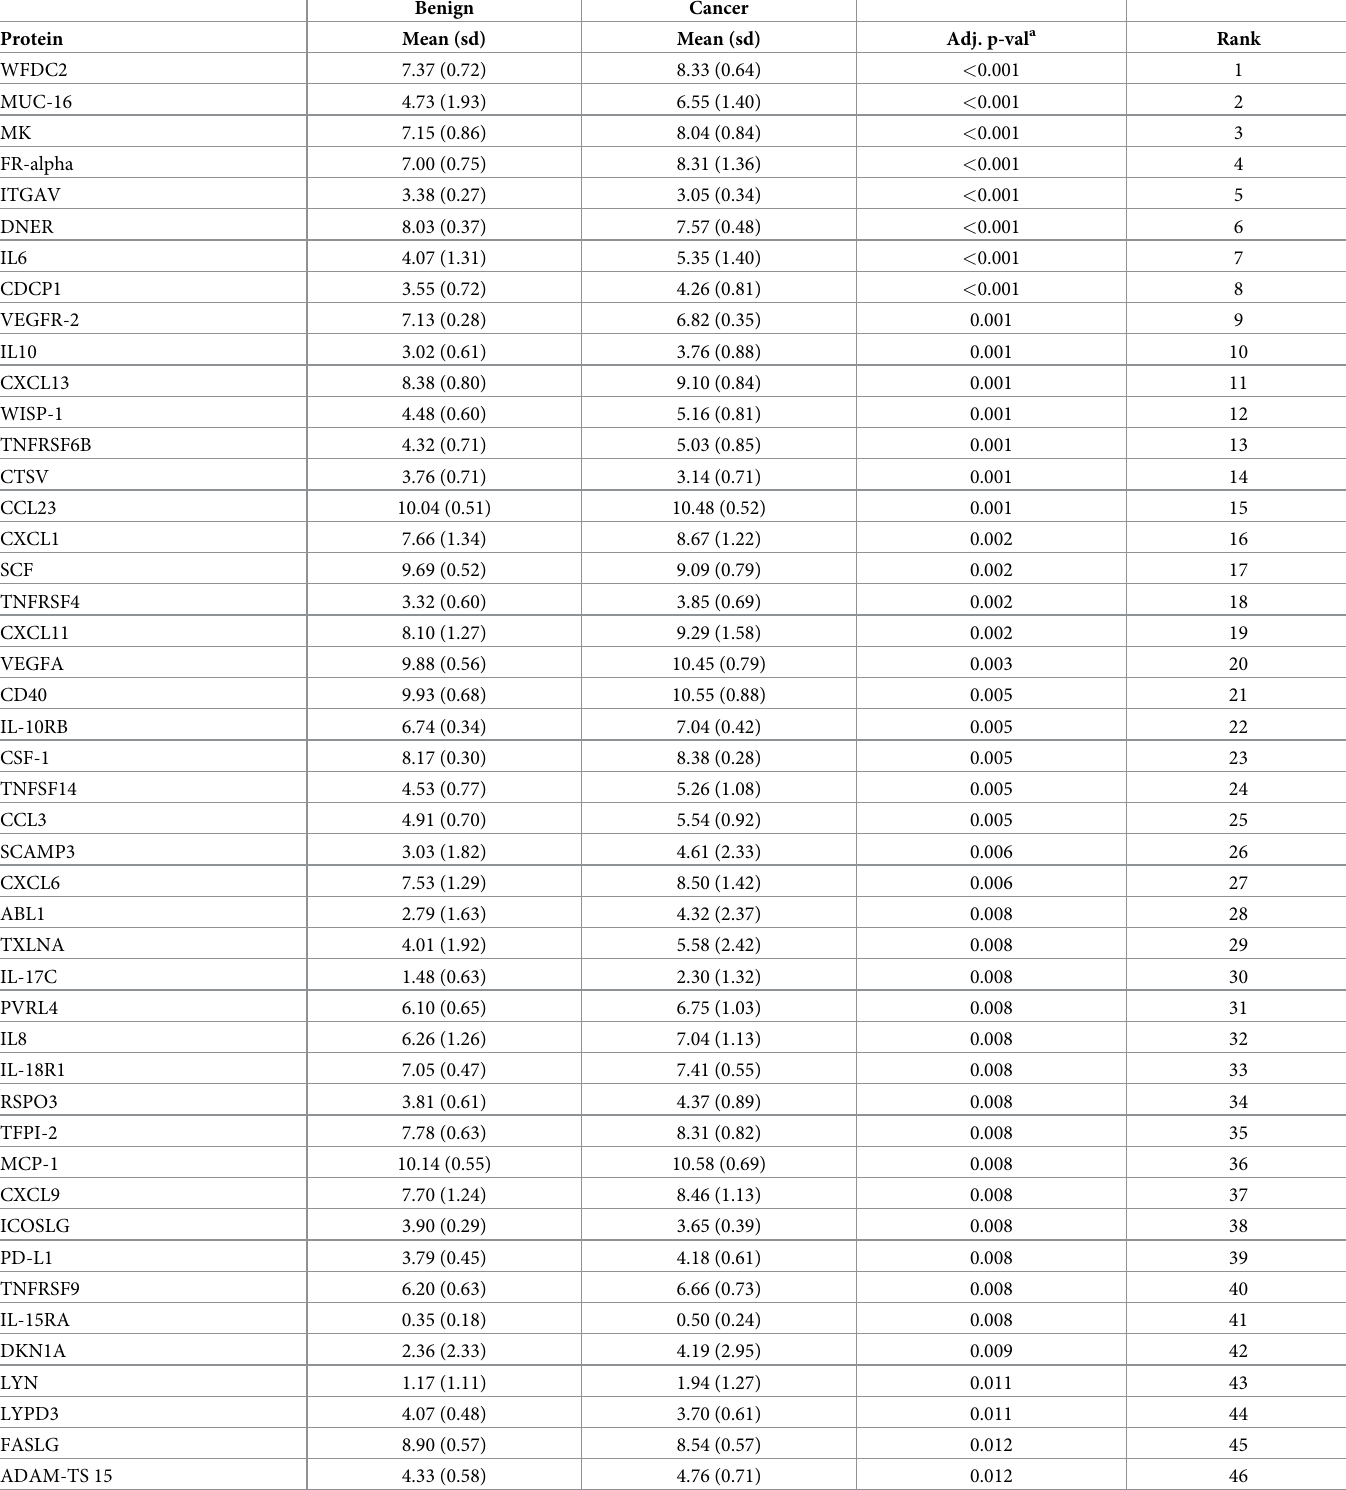
Table 2. Normalized protein expression (NPX) values. Benign tumors vs. cancer, p < 0.05.